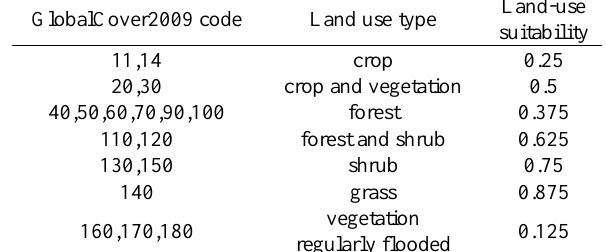
Table 3. The land-use suitability